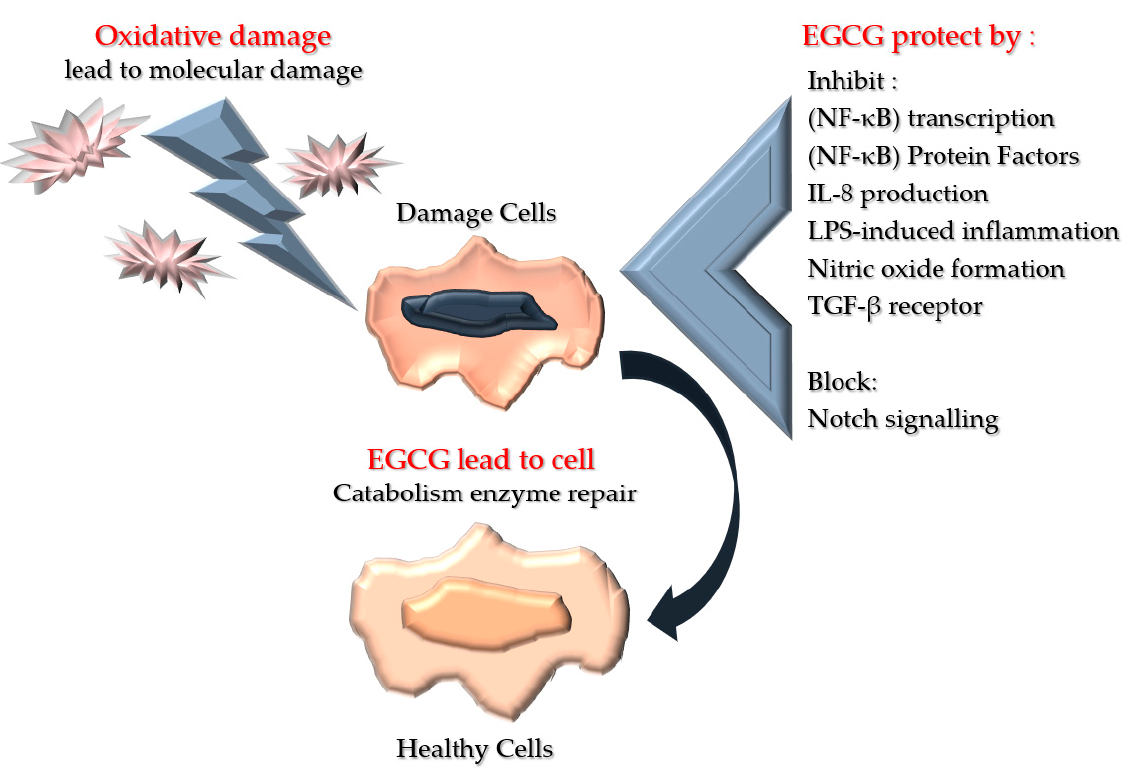
Figure 6. Illustration of the mechanism of EGCG towards molecular damage. This molecular damage will lead to vital damage towards the cell’s continuous development, and hence cell apoptosis. However, the antioxidant properties of EGCG are able to overcome oxidative damage and lead to cell recovery and enzyme repair. Table 1. Epigallocatechin gallate (EGCG) wound healing potential .